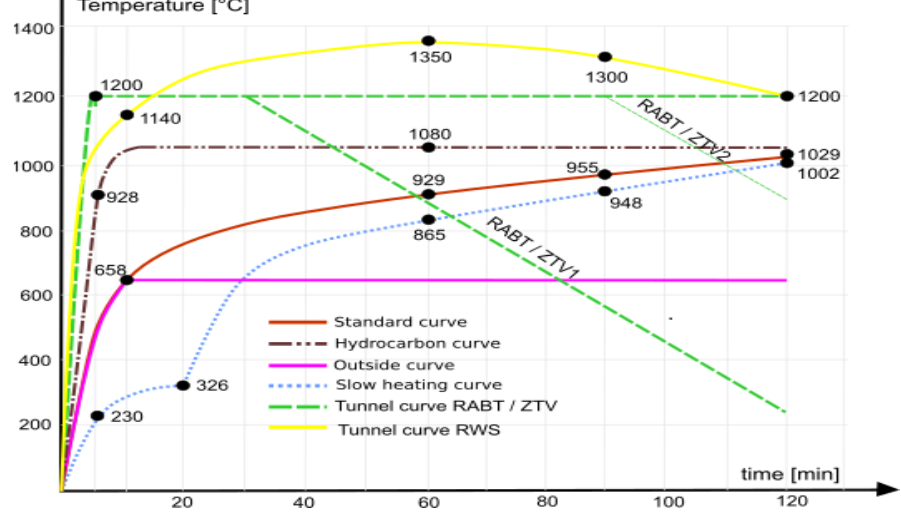
Figure 1. Comparison of fire curves.